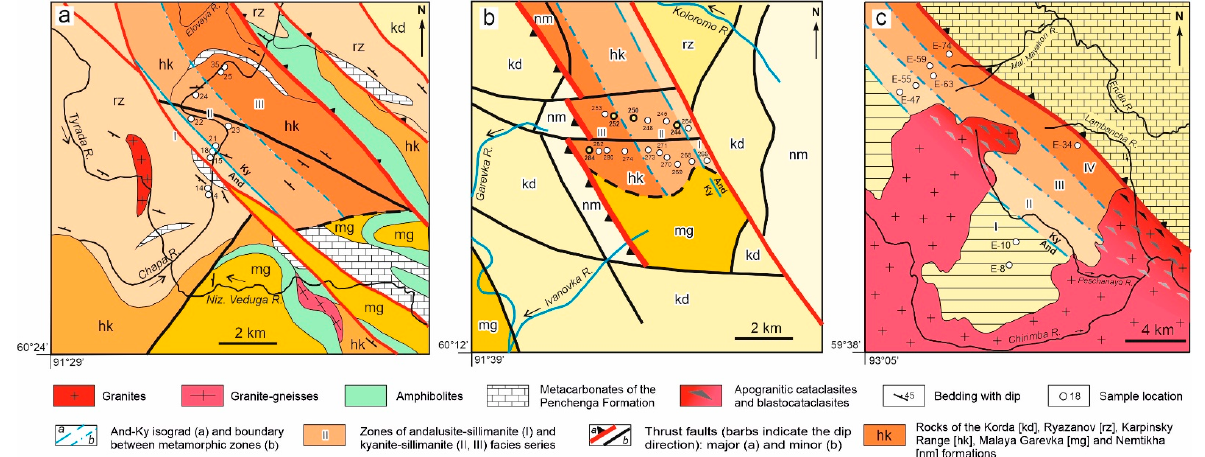
Figure 11. Sketch map of the polymetamorphic complexes: Chapa ( a ), Polkan ( b ), and Mayakon areas ( c ).